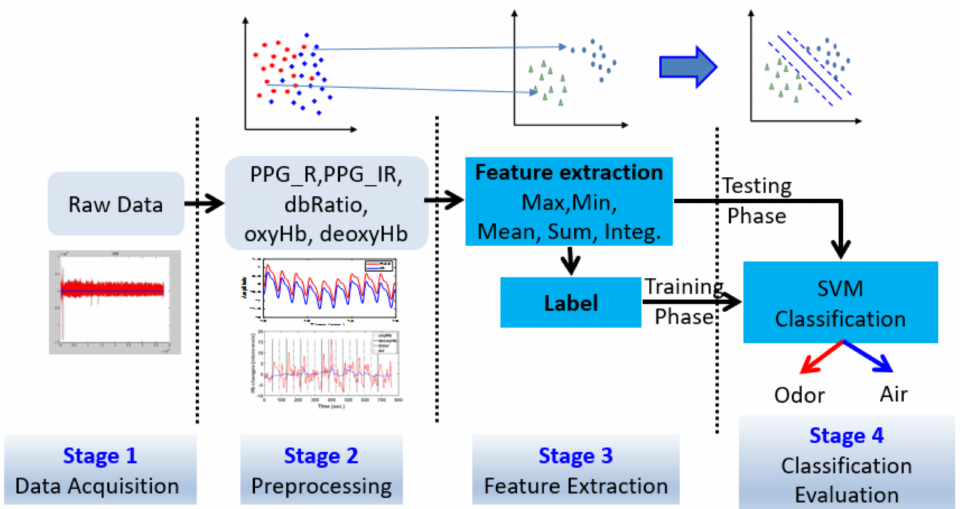
Figure 3. Flow chart of signal processing using the present machine learning approach to separate odor and air classes through photoplethysmography (PPG-R, PPG-IR, and dbRatio) and hemoglobin response function (including oxyHb and deoxyHb) signal